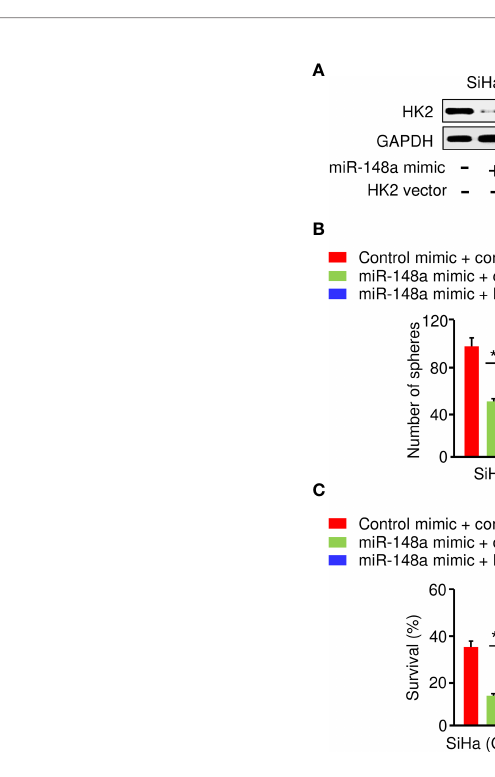
FIGURE 6 | The MiR-148a/HK2 Axis Mediates Sphere Formation and CDDP Resistance in CC Cells. (A) Western blot analysis of HK2 expression in CC cells transfected as indicated. (B) Sphere formation of CC cells transfected as indicated. (C) Cell viability of CC cells transfected as indicated in the presence of CDDP was detected by the cell viability assay. *** P <